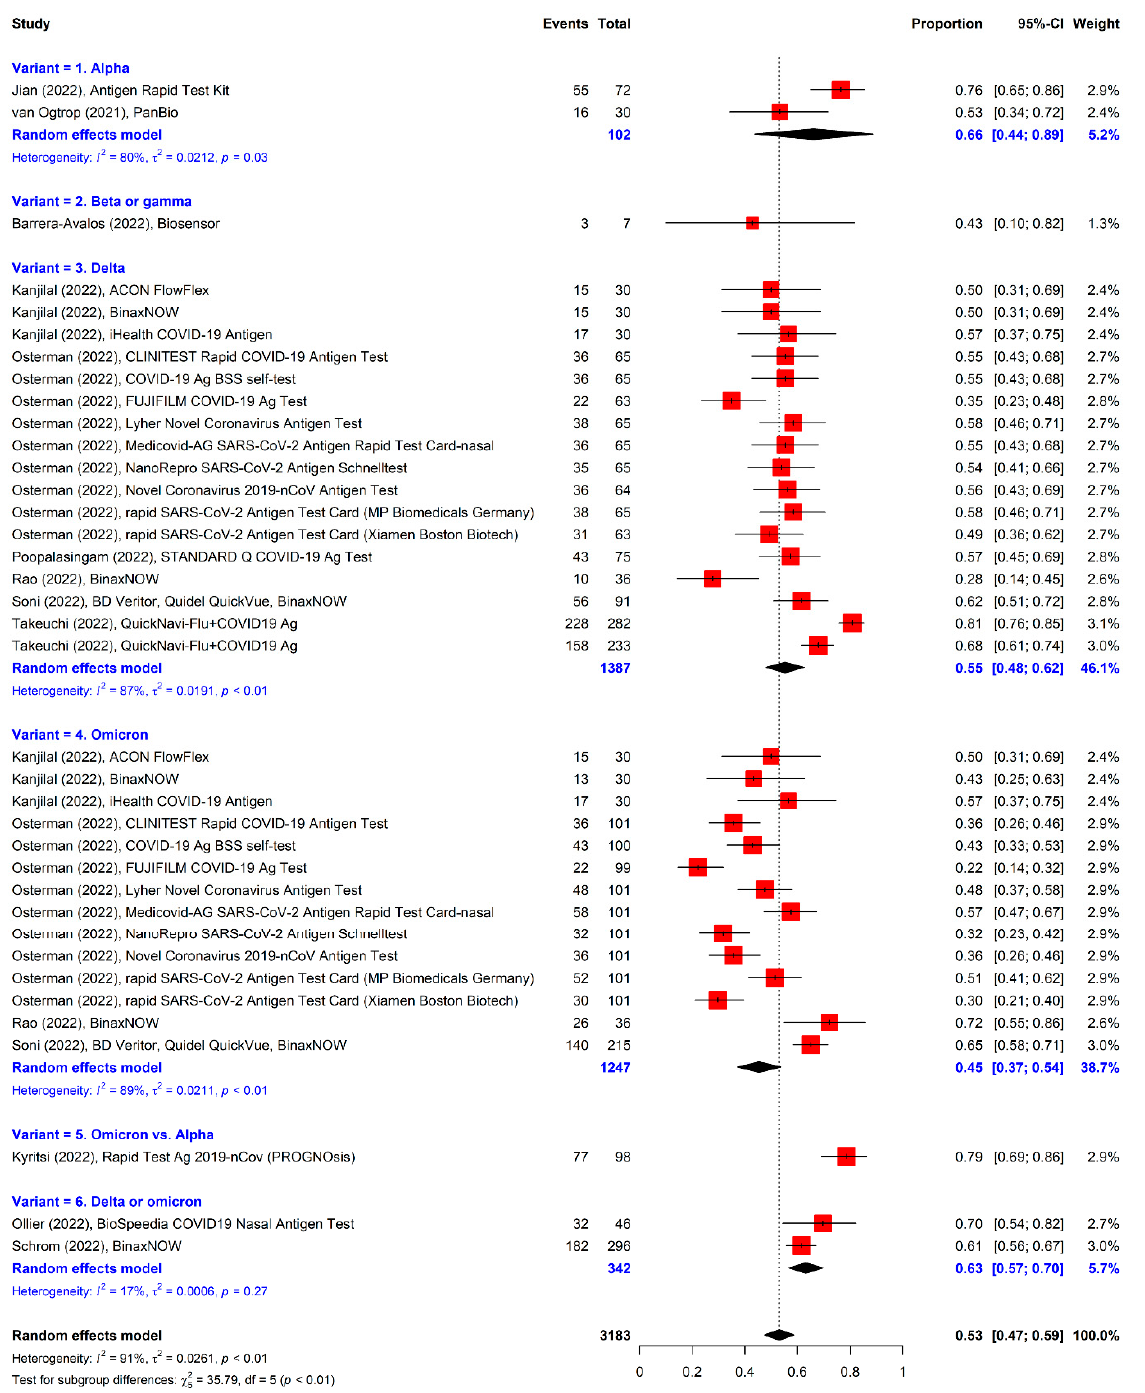
Figure 8. Forest plot using univariate analysis only for the sensitivity of RATs.